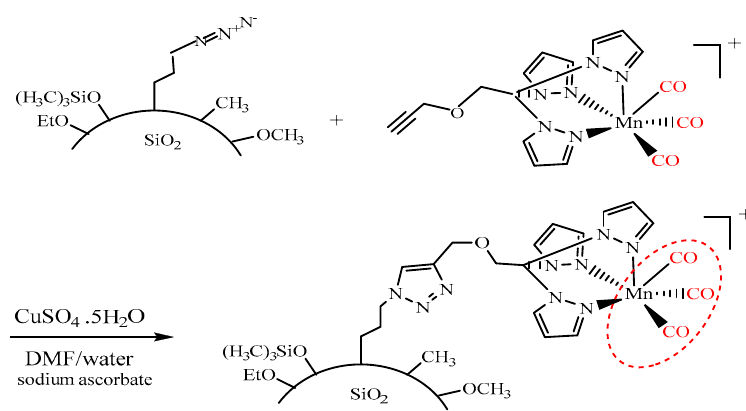
Figure 25. The mechanism of Manganese tricarbonyl functionalized with silica nanoparticles.